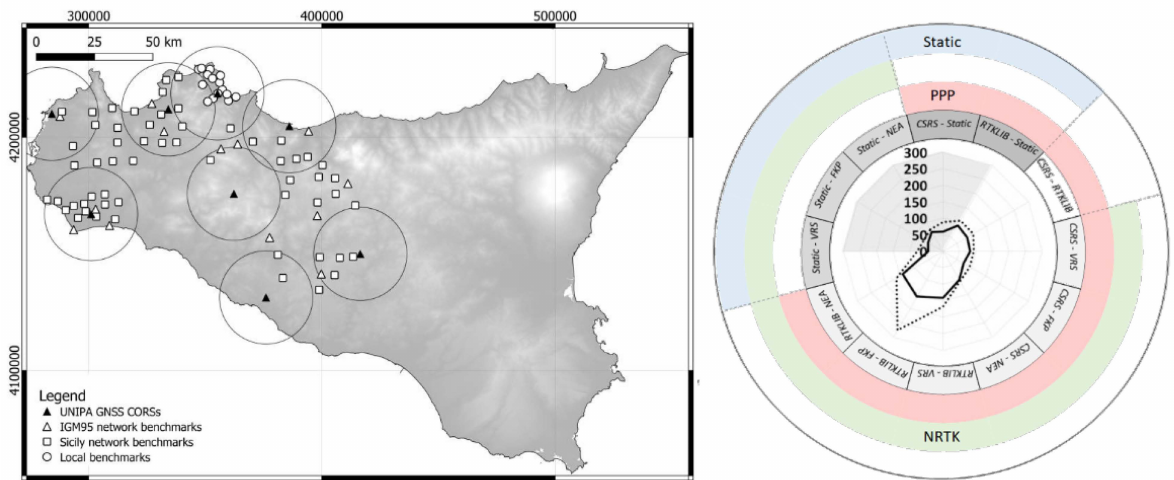
Figure 12. Different solutions for GNSS NRTK, PPP or static positioning. Left: UNIPA GNSS CORSs (black triangles) and GNSS reference benchmarks (IGM95 network benchmarks with white triangles; Sicily network benchmarks with white squares; and local benchmarks with white circles). 20 km buffer circles from the GNSS CORS are shown. Reference system UTM-WGS84 33N (ETRF2000- RDN2008)-EPSG6708. Right: ∆ h differences, pre- and post-outliers’ removal (dashed and continuous lines, respectively)